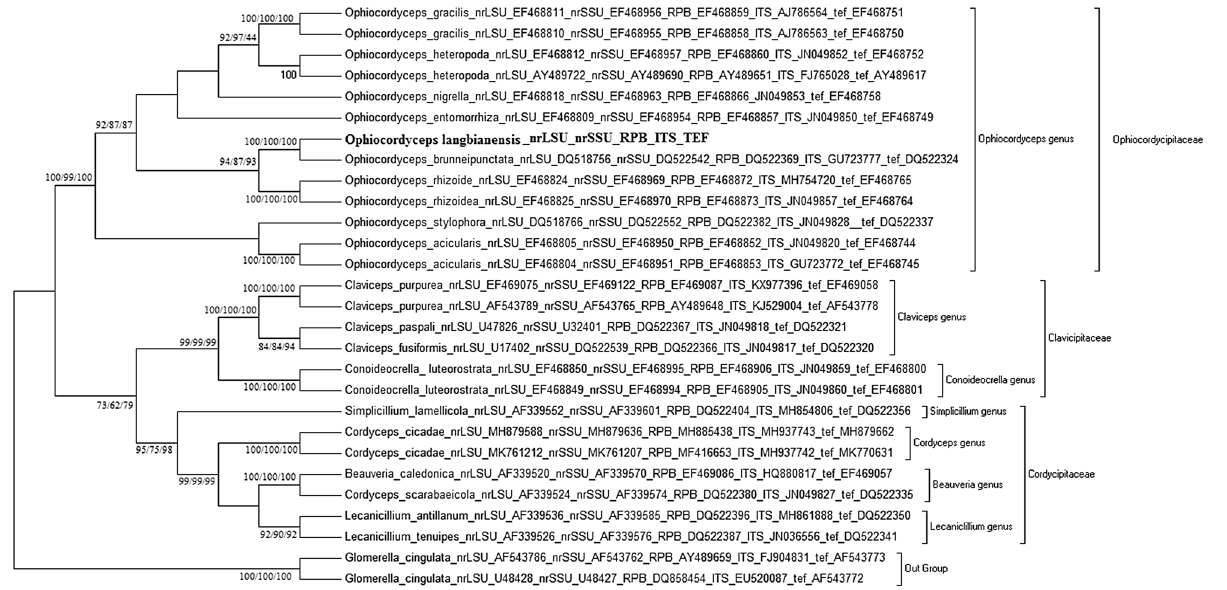
Figure 4. Phylogenetic relationship between O. langbianensis and its allies based on five regions, nrLSU - nrSSU - Rpb - ITS-tef data. Bootstrap values (1,000 replicates) are indicated above the